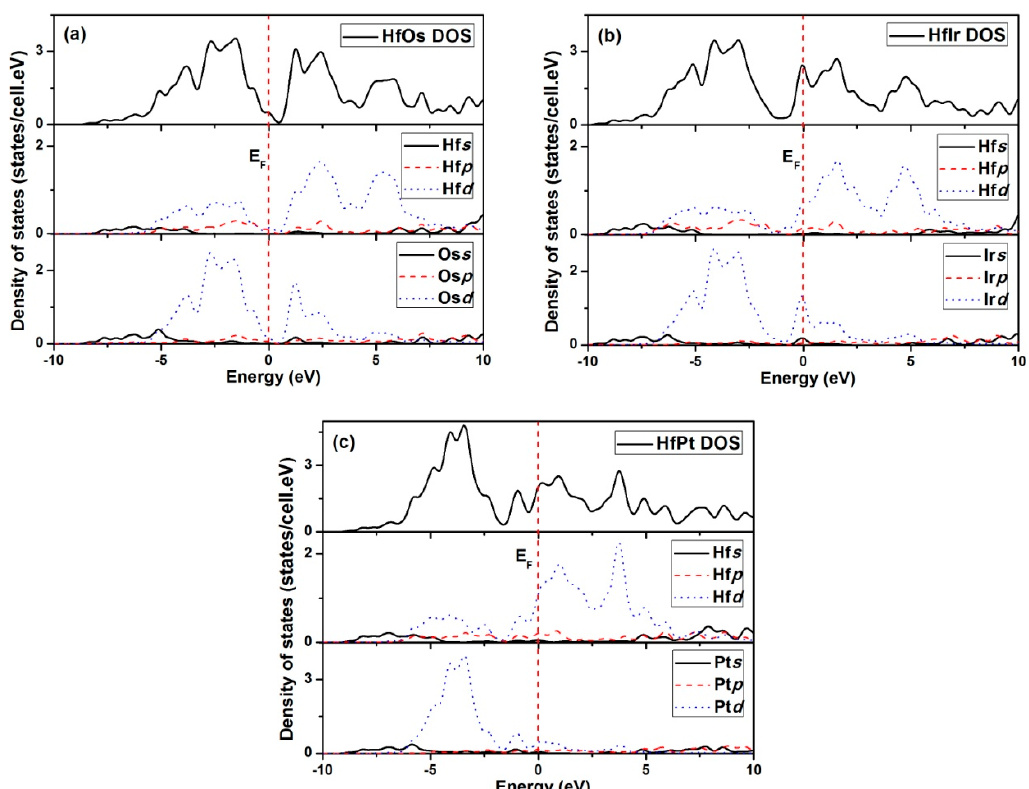
Figure 2. TDOS and PDOS spectra for ( a ) HfOs, ( b ) HfIr and ( c ) HfPt.